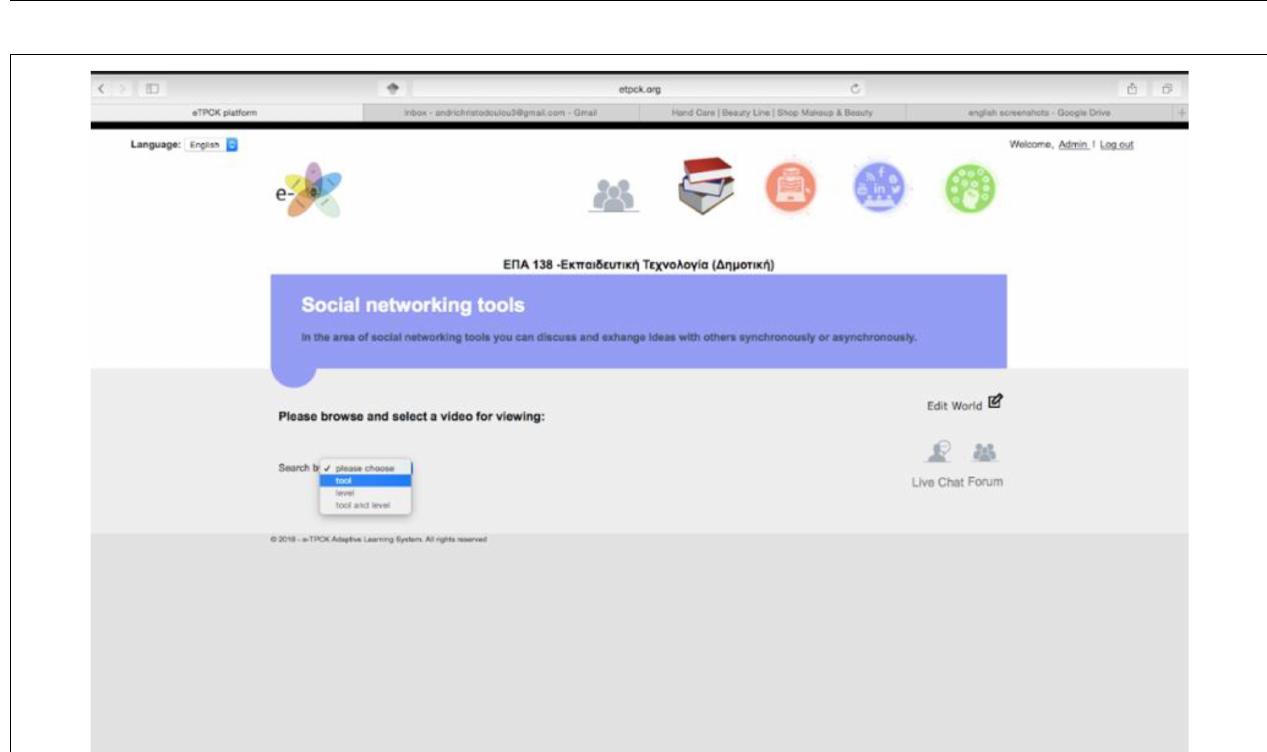
FIGURE 2 | Social networking tools